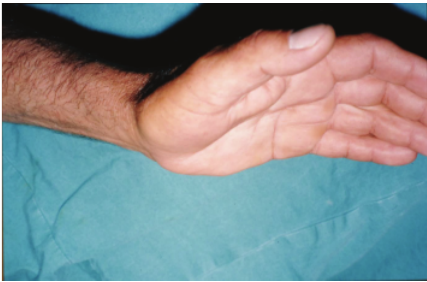
Figure 1: Preoperative appearance of distal ulnar artery thrombosis.